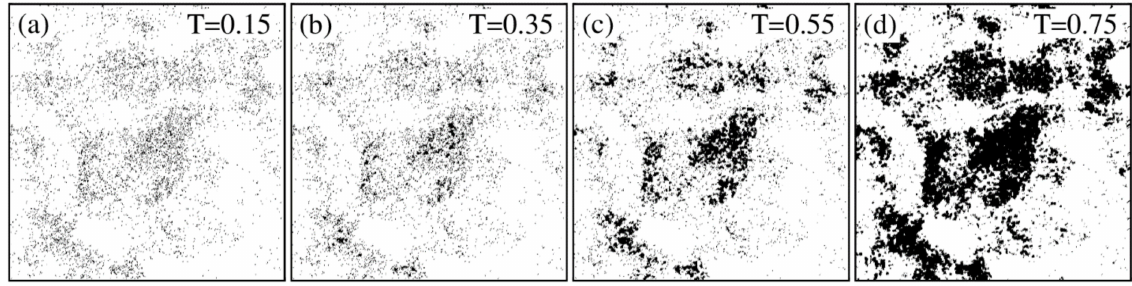
Figure 13. Point hierarchical results under different thresholds, where white represents high-quality first-level phase points, and black represents low-quality second-level phase